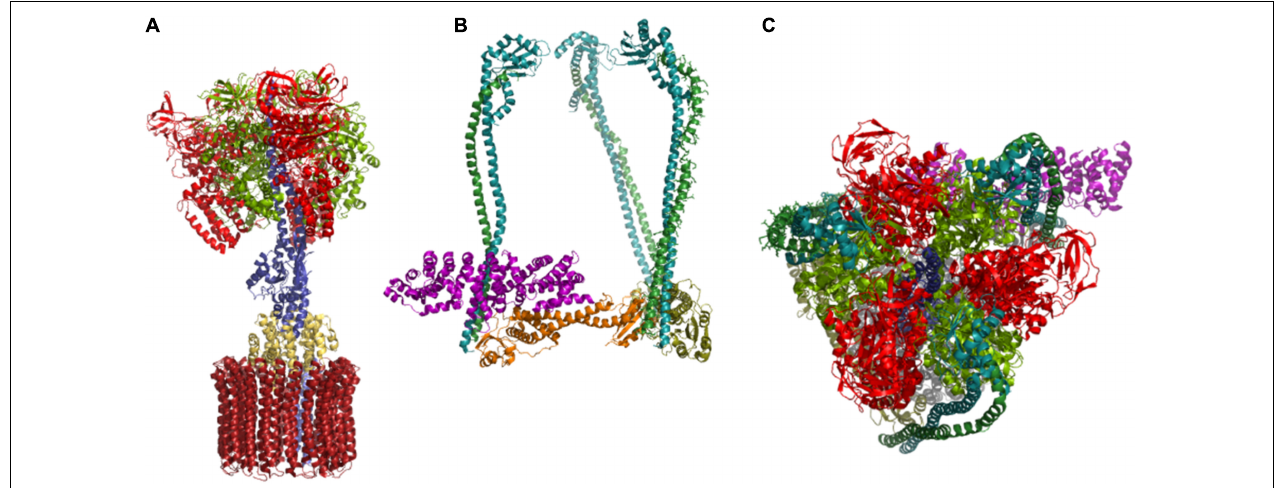
FIGURE 4 | Structure-function relationship of the subunit arrangement. (A) Subunits that are directly involved in catalysis of proton pumping are given, starting with ATP-hydrolysis at the catalytic head, transformation of conformational changes into rotation of the central shaft by VHA-D and VHA-F, and VHA-d-mediated transduction of the rotation to the proteolipid ring, are given. VHA-a contributes the semi-channels for loading and unloading of proton binding sites. (B) The peripheral stalk subunits form a structure that resembles a rigid cage. It anchors the catalytic head to the membrane and prevents its co-rotation. Subunits of the peripheral stalk have a direct impact on coupling ratio. (C) Top view of the V 1 sector reveals the arrangement of VHA-A subunits with VHA-D located in the center. The structures are based on pdb 3j9t (Zhao et al.,